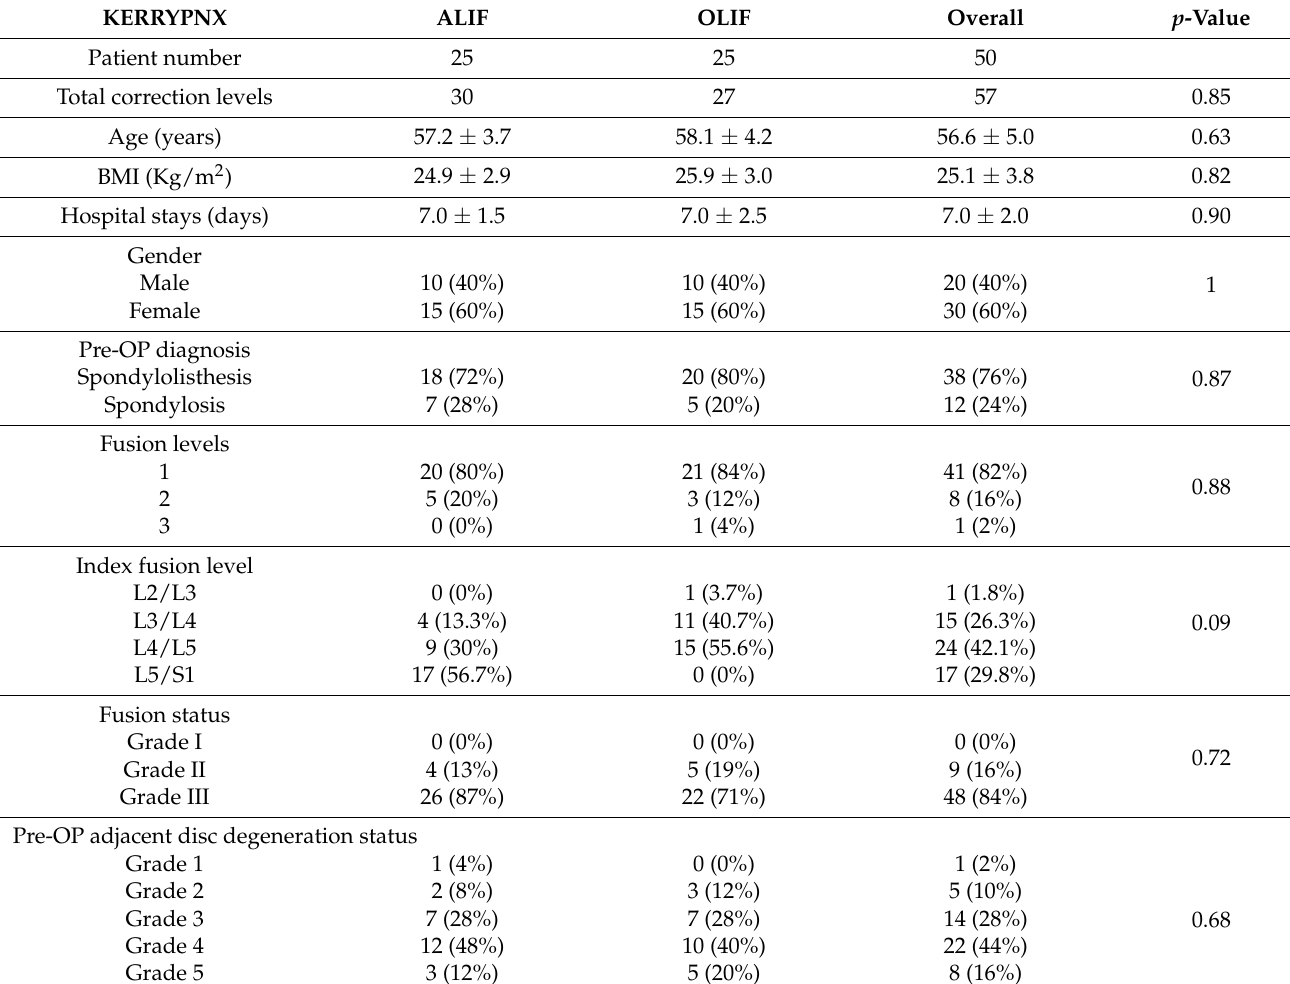
Table 1. Demographic data of the study population stratified by lumbar interbody fusion